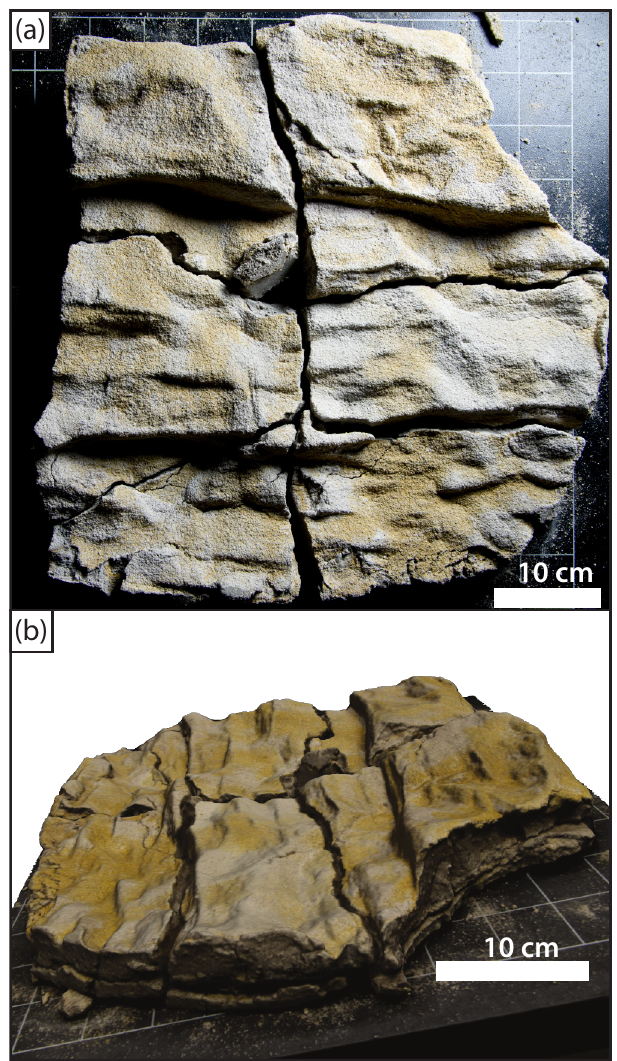
Figure 10. Geometry of stair-steps at the footwall side of a clay smear (cf. Fig. 7a for location): (a) shadows reveal the structure, light source in upper right corner; (b) oblique view at a 3-D model created by photogrammetry – stair-steps resemble sudden changes in clay smear thickness. 3-D model is available in the Supplement.